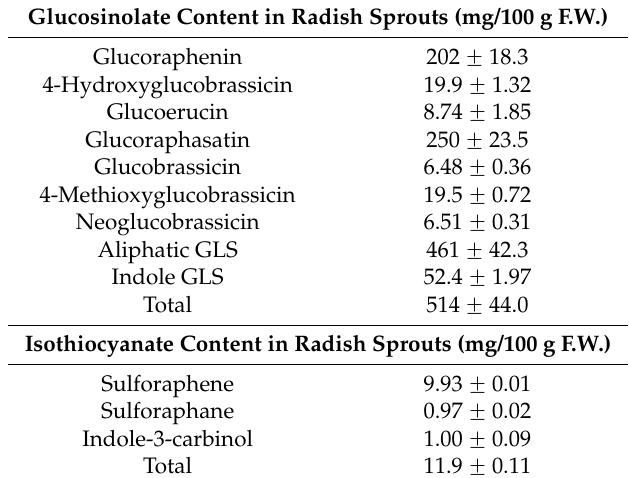
Table 1. Quantification of glucosinolates and isothiocyanates in radish sprouts.